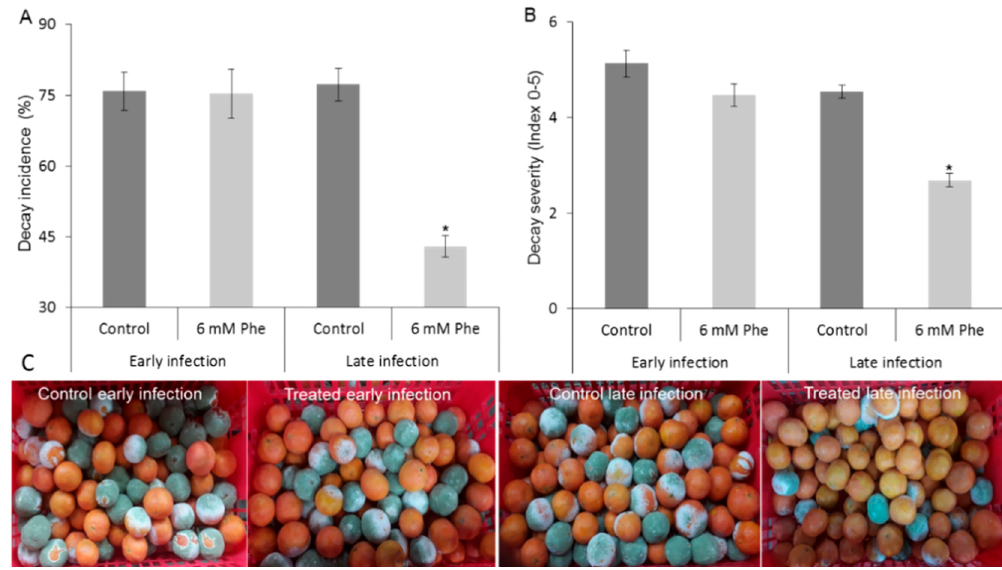
Figure 5. Induced resistance by phenylalanine application in mandarin fruit. “Michal” mandarin fruits were treated with water (Control) or 6 mM phenylalanine. Then, the fruit was either immediately inoculated with P. digitatum (early infection) or inoculated 2 days after the phenylalanine application (late infection) and stored at 22 °C. Decay was evaluated 5 days later. ( A ) Decay incidence (percentage of rotten fruit). ( B ) Decay severity (index, 0–5). ( C ) Representative picture of mandarin fruit treated with 6 mM phenylalanine compared to controls, under early- and late-infection protocols. Values are mean ± SE. Asterisk (*) represents a statistically significant difference between the treatment and control according to t-tests p ≤ 0.05.